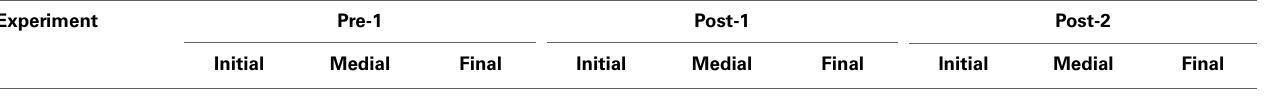
Table 2 | Phoneme identification scores in Experiments 1 and